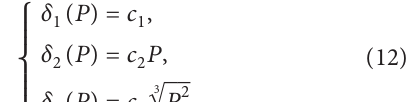
reducer under torque 100 N · m is calculated and shown